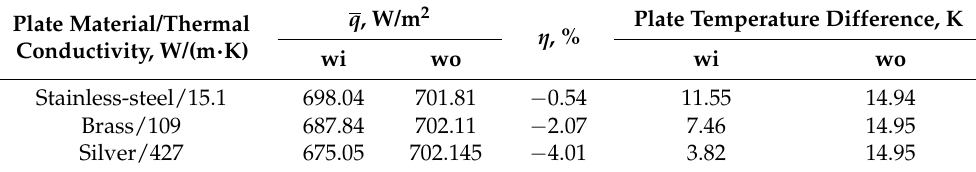
Table 3. Results of calculation for different plate materials counter-flow plate heat exchanger in balanced flow: average heat flux q ; contribution of longitudinal heat conduction η ; plate temperature difference. Plate Temperature Difference, K q , W/m 2 Plate Material/Thermal η , % Conductivity, W/(m · K) wi wo wi wo Stainless-steel/15.1 698.04